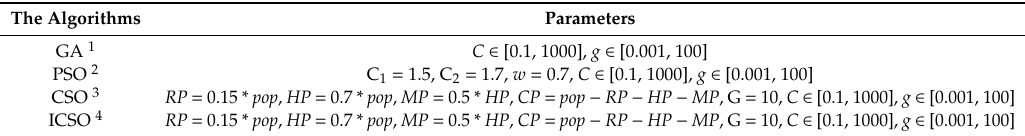
Table 2. The parameters of the four algorithms.